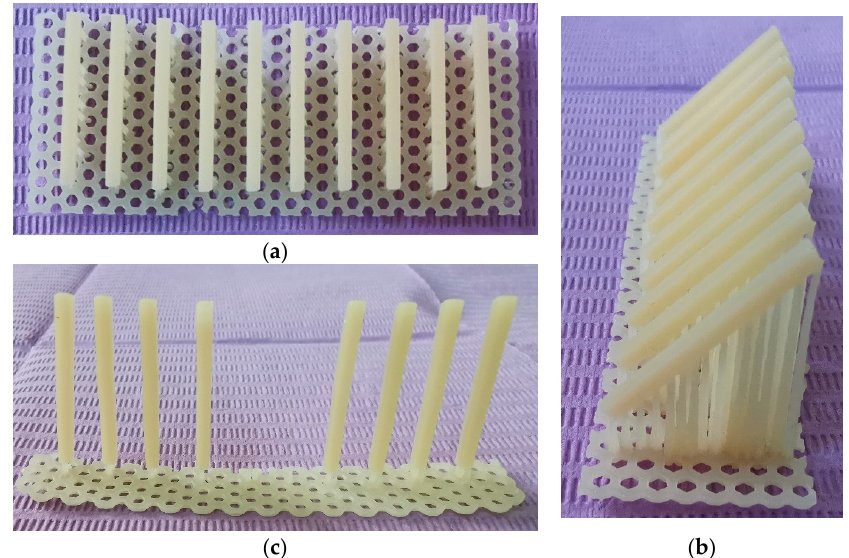
Figure 1. The printed specimens made of DETAX on three different directions: 0, 45 and 90 degrees. ( a ) 0°; ( b ) 45°; ( c ) 90°.